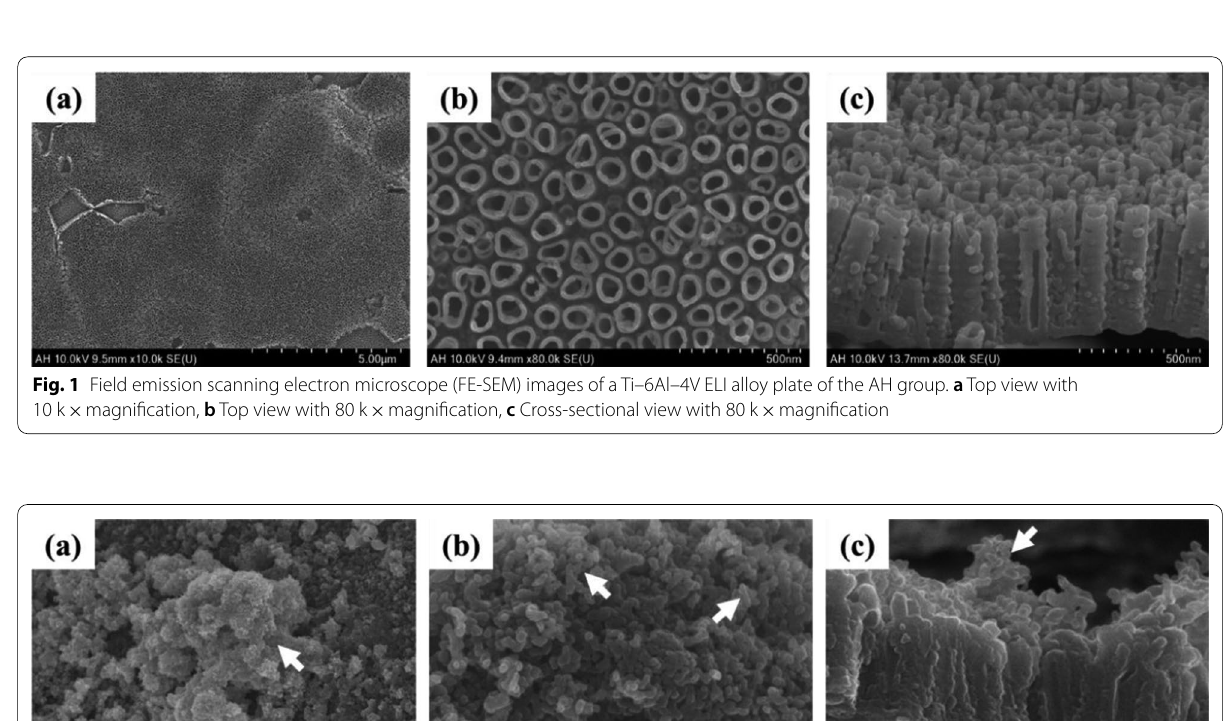
magnification, b Top view ×